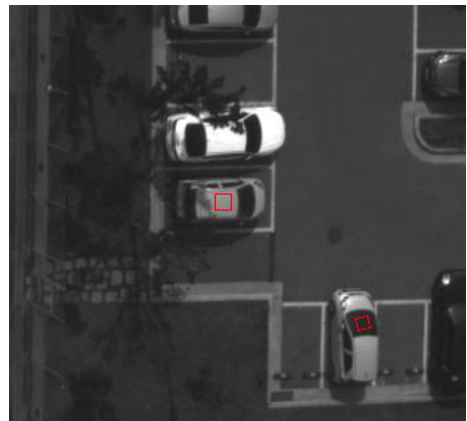
Figure 9. Semi-automatic target detect result.